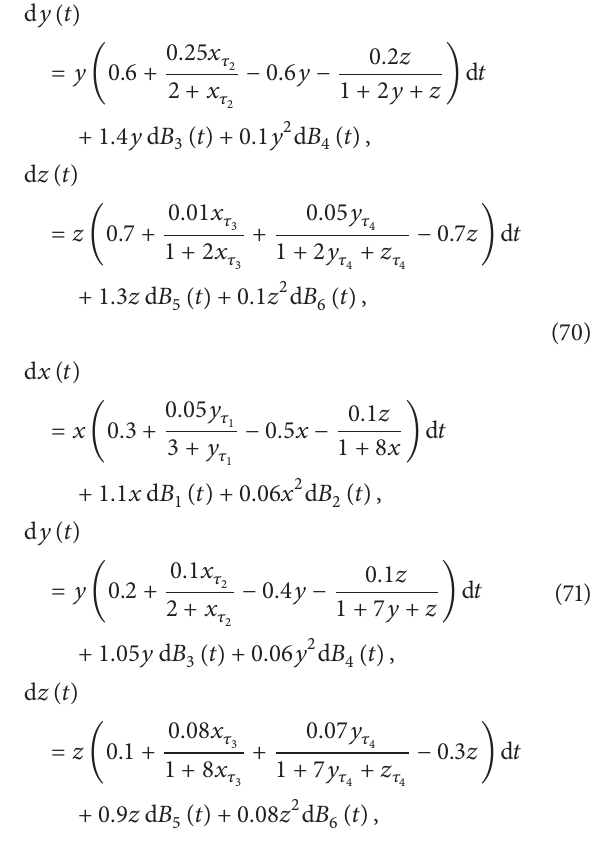
Figure 4: The subgraphs (a) and (b) denote the trajectory and frequency of the discrete Markov chain 𝑟 𝑛 taking value in {1,2} , respectively. = 1 and 𝑟 = 2 mean that the overall system (5) switches to subsystems (64) and (65) in step 𝑛 , respectively. The change of 𝑟 𝑟 𝑛 𝑛 the process of regime switching of system (5) between subsystems (64) and (65). And the frequency of 𝑟 𝑛 in (b) shows the result of regime switching—the total number of steps of the overall system (5) switching to subsystem (64) or subsystem (65). This graph shows that under the control of the Markov chain the overall system (5) mostly switches to subsystem (64) in Case 1 of Example